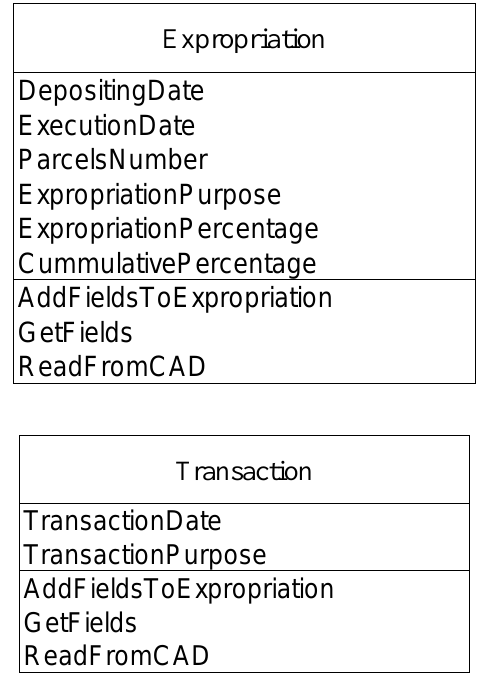
Figure 2. An example for the "Expropriation" and "Transaction"